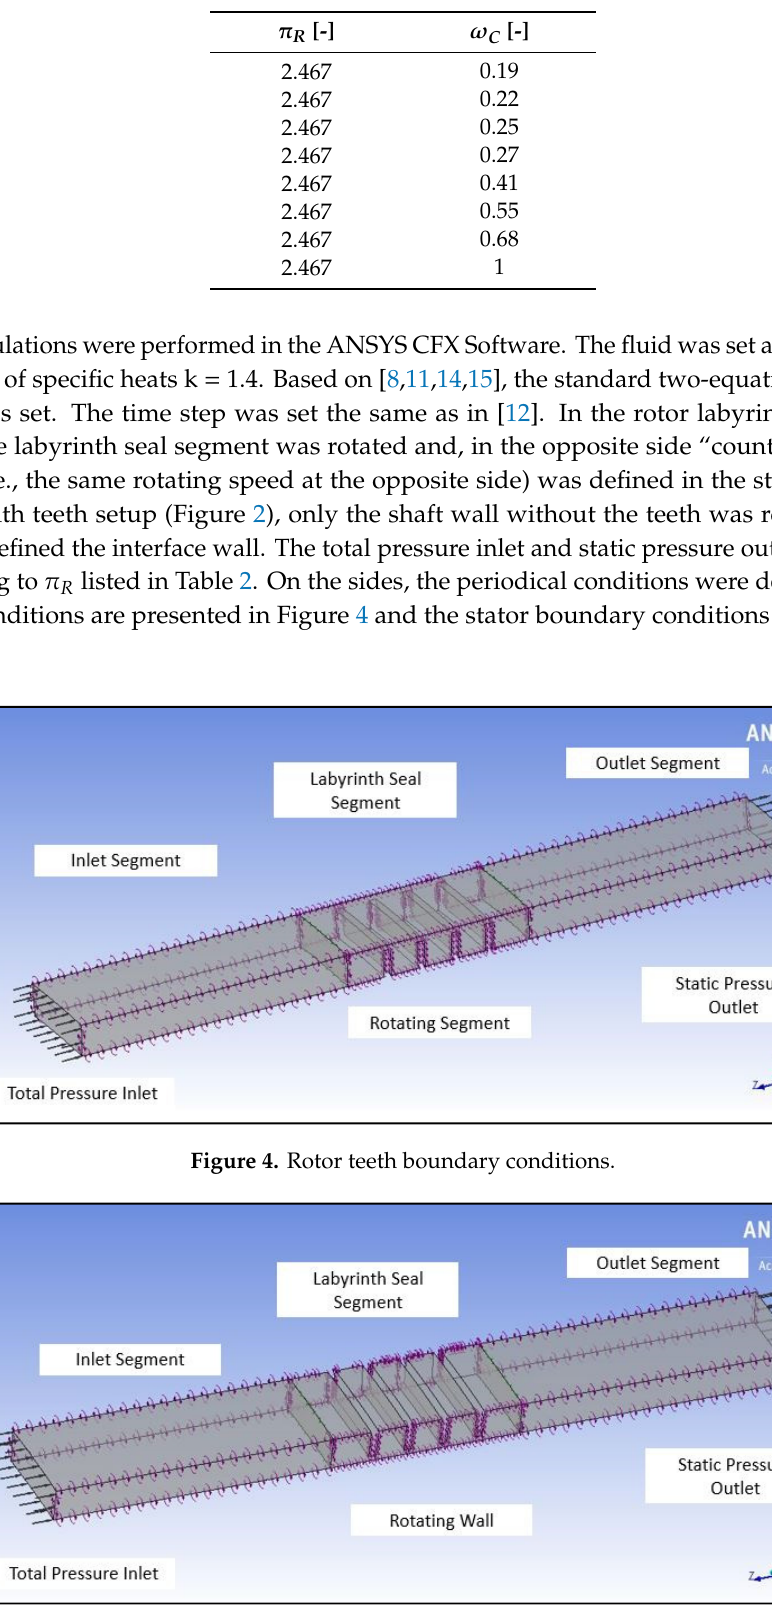
Figure 5. Stator teeth boundary conditions.